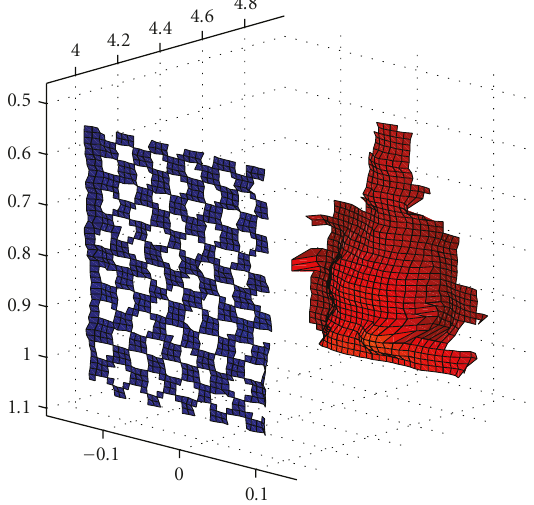
Figure 9: Fence layer and the reconstructed 3D image of the mannequin layer with interpolation and smoothing techniques.